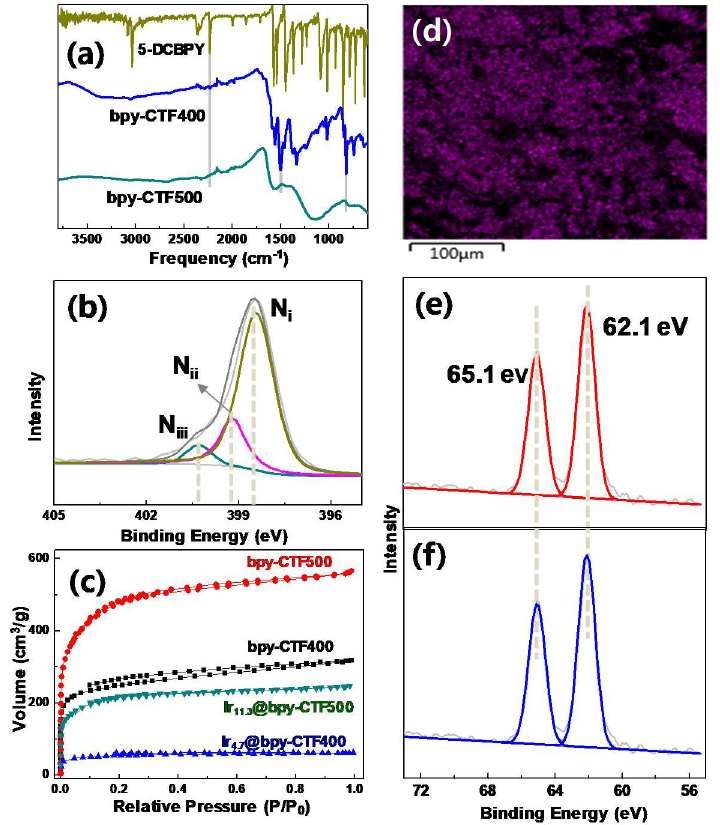
Figure 2. Structural characterization of bpy-CTF500 and Ir 11.3 @bpy-CTF500 . ( a ) FT-IR spectra of bpy-CTFs. ( b ) XPS of N 1s deconvolution spectrum of bpy-CTF500. ( c ) N 2 adsorption-desorption isotherm.